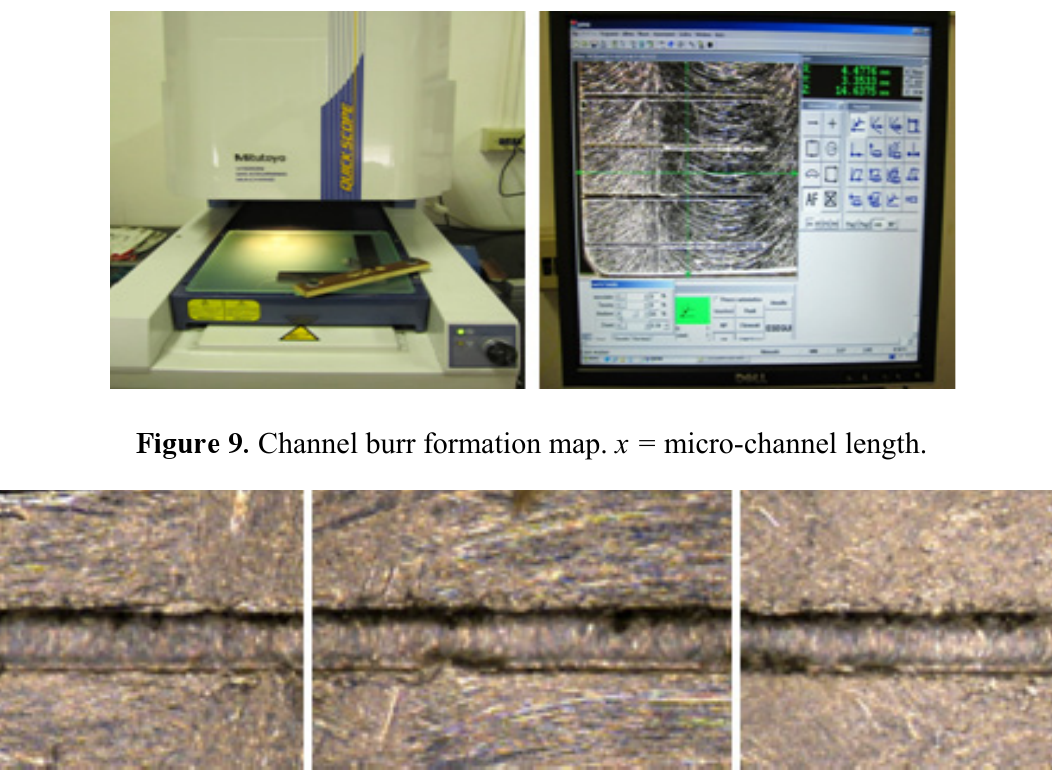
Figure 8. Mitutoyo QuickScope QS200Z & QSPAK software.